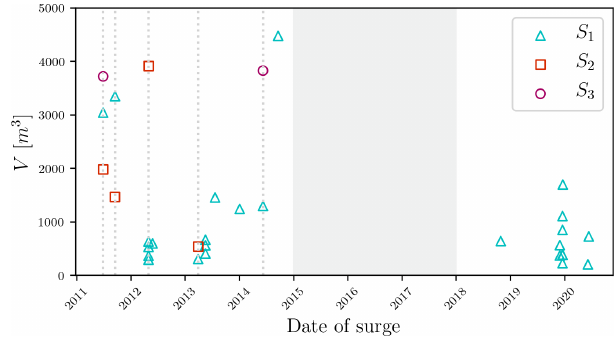
Figure 9. Volume of the surges of mature debris flow passing the stations; the grey area has no data partly due to a faulty sensor in- validating measurements from 2016 until the end of 2017 when the sensor was replaced. No surges were detected in 2015. Dotted grey lines represent dates for which the surge was detected at multiple